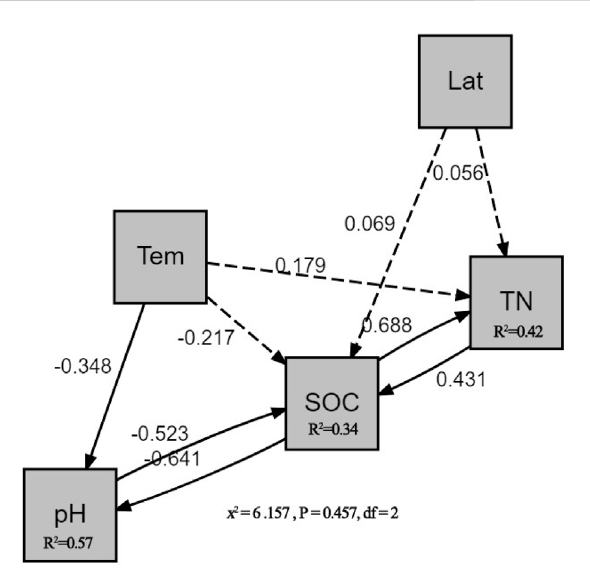
Driven factors of grazed grasslands SOC on the Tibetan Plateau by structural equation model. Note: pH, Tem, SOC, TN, and Lat were pH value, air temperature, soil organic carbon, total nitrogen, and latitude. Solid and dotted lines indicated signi fi cant and insigni fi cant effect,